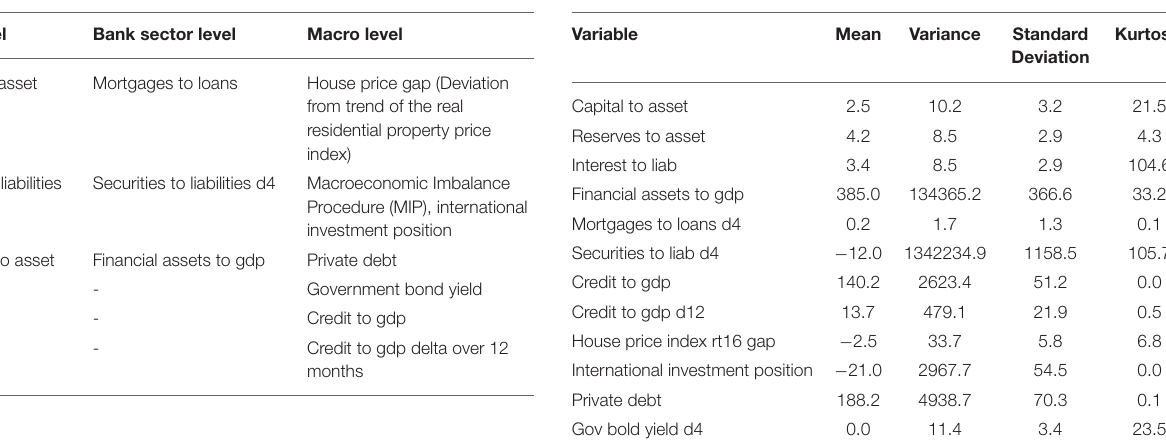
TABLE 1 | List of available numerical variables. TABLE 2 | Summary statistics of available numerical